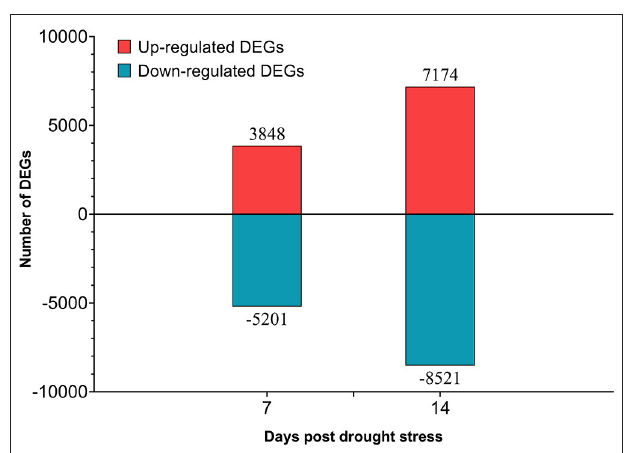
FIGURE 9 | Number of differentially expressed genes (DEGs) in different drought stress